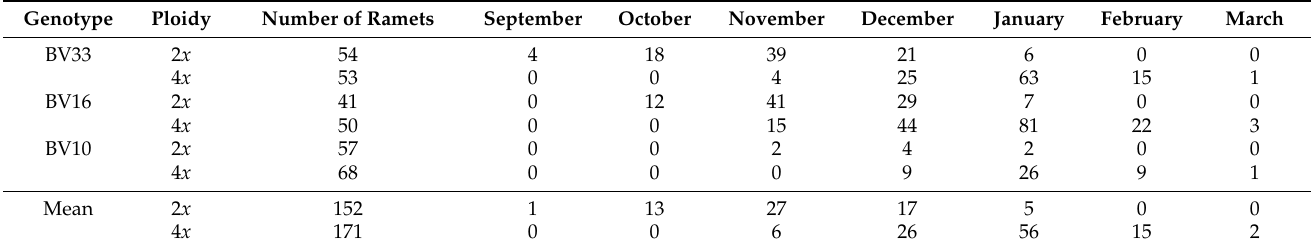
Table 2. The percentage of ramets flowering in the Bau Bang trial each month for the three diploid clones and their combined derived tetraploid lines.